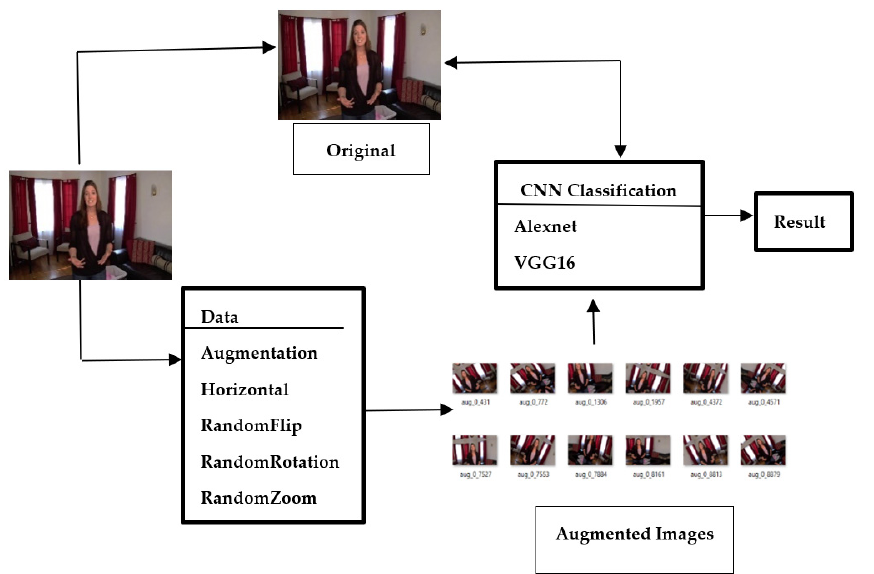
Figure 2. The framework of the proposed classification transfer learning models with the image data augmentation method.